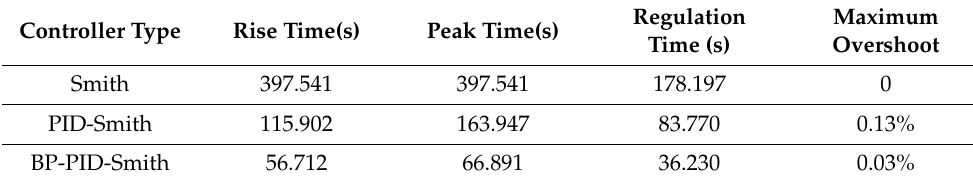
Table 1. Comparison of the dynamic performance of the three controllers for model